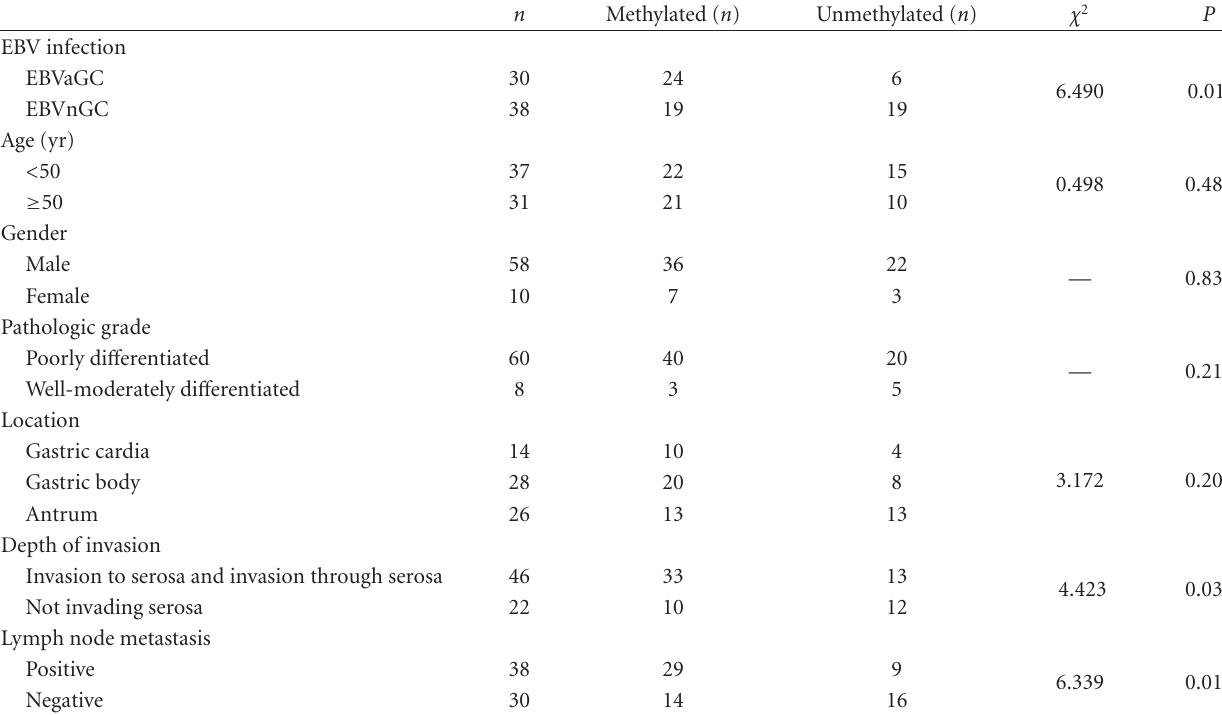
Table 3: Correlation of methylation status of RB gene with clinicopathological data of gastric carcinoma patients. n